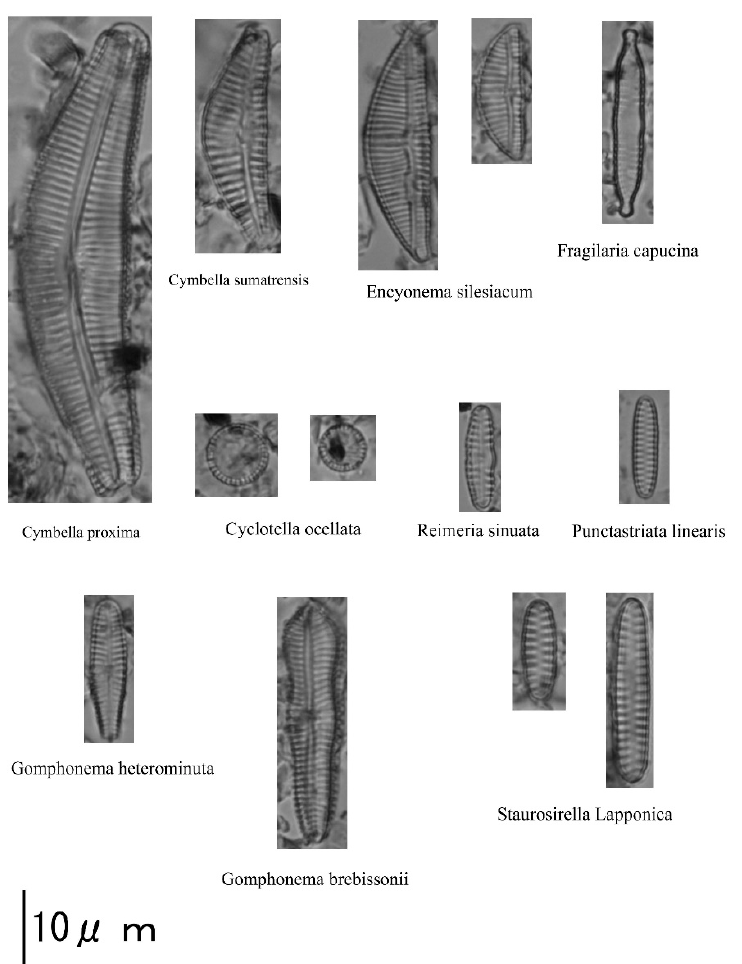
Figure 6. The dominant species of the diatom assemblages in 50 cm depth for the core TU08 in the Tuul River basin.